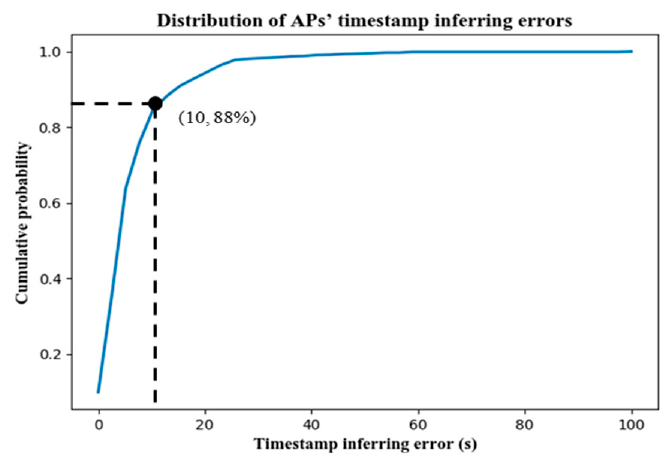
Figure 21. The CDF of AP’s timestamp inferring errors.